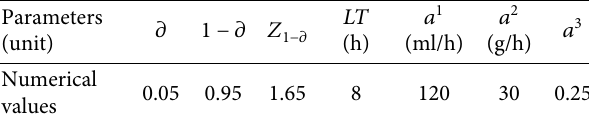
Table 12: Settings of relevant parameters.